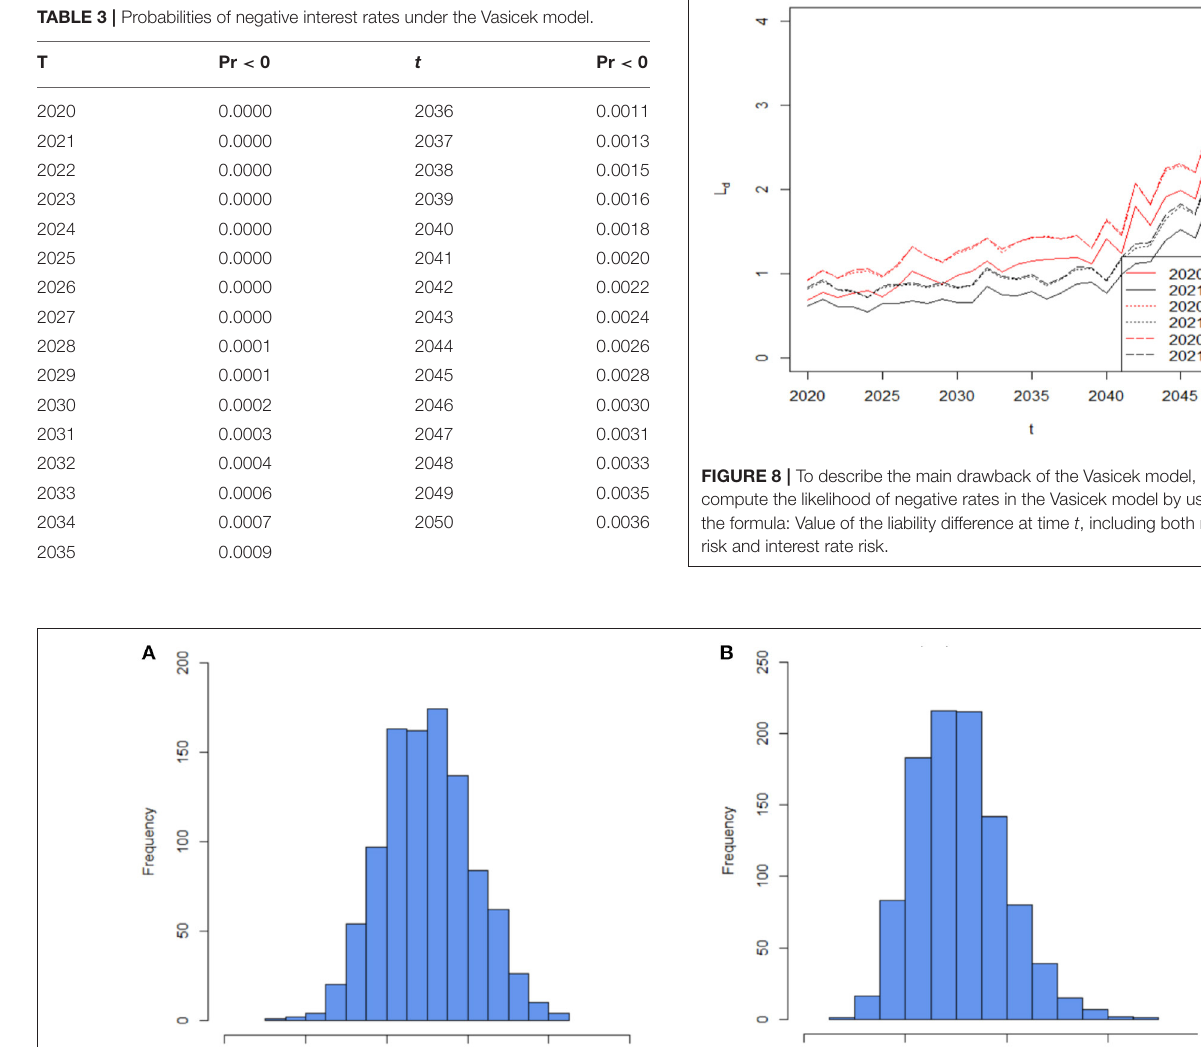
2050 based on the CIR model. =